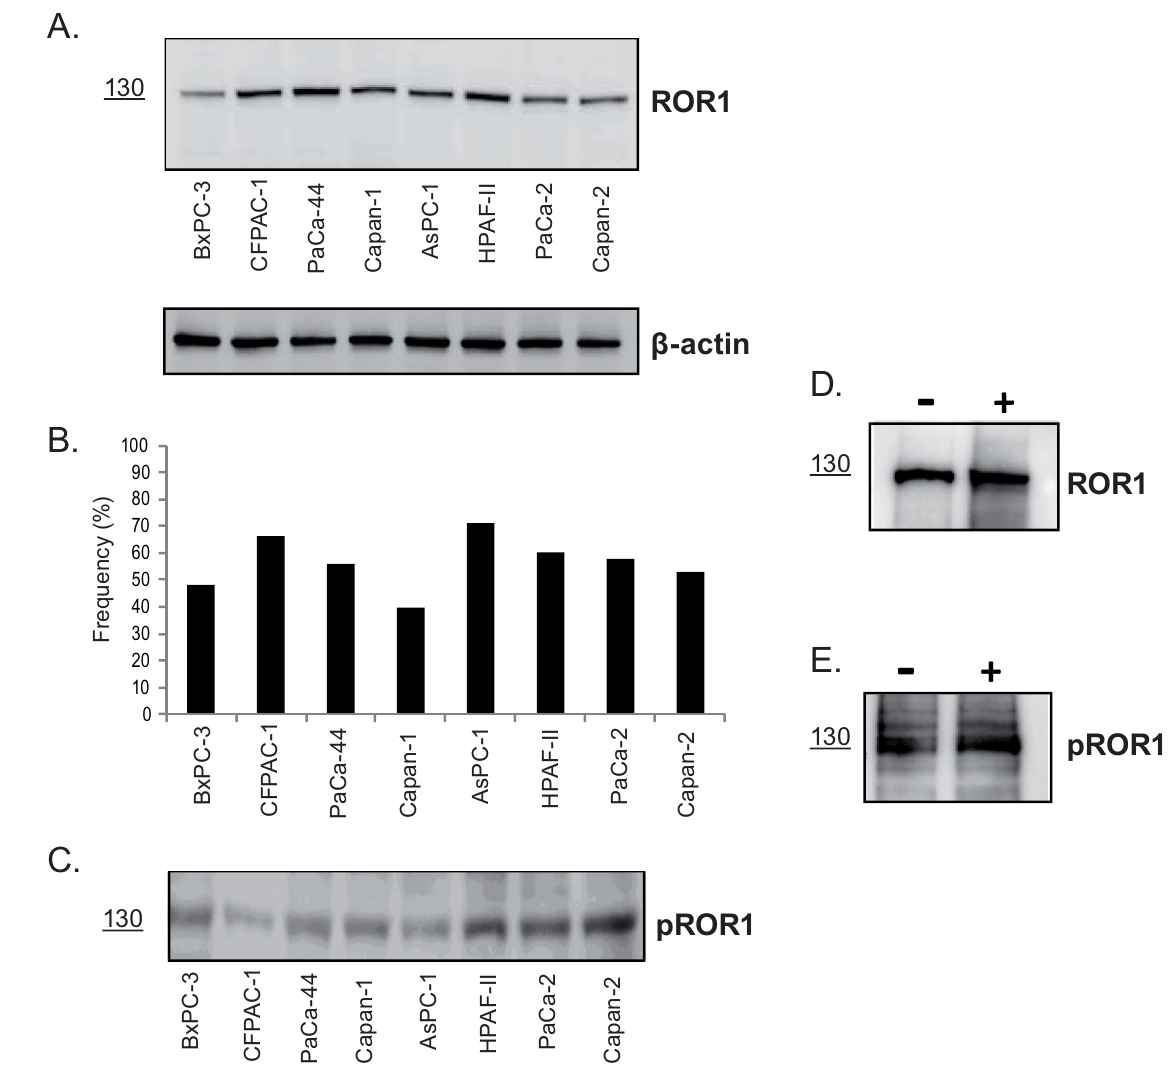
Fig 1. Expression of ROR1 in 8 human pancreatic cancer cell lines. (A) ROR1 expression by Western blot (The fully glycosylated ROR1 protein is 130 kDa) [11]. β -actin was used as loading control. (B) Frequency (mean ± SEM) (%) of surface ROR1 + cells (flow cytometry). [Statistically significant difference (p-values (cid:20) 0.01) were: BxPC-3 vs AsPC-1 < 0.01; CFPAC-1 vs Capan-1 < 0.01; Capan-1 vs AsPC-1 < 0.01; AsPC-1 vs Capan-2 = 0.01]. (C) Expression of phosphorylated ROR1 protein (pROR1) (130 kDa). ROR1 and pROR1 expression in surface ROR1 positive (+) and negative (-) PaCa-2 cells (cell sorting). (D) A 130 kDa ROR1 protein was detected (Western blot) in both the ROR1 + and ROR1 - fractions. (E) ROR1 + and ROR1 - fractions expressed a pROR1 protein (130 kDa). Using cell lysates of the PaCa-2 cell line from the 24 h of culture (Fig 2A), it could be shown that KAN0439834 and anti-ROR1 mAb induced both PARP and caspase-3 cleavage as well as downregulation of the MCL-1 and Bcl-xL proteins (Fig 2B and 2C) confirming induction of apoptosis by both compounds.